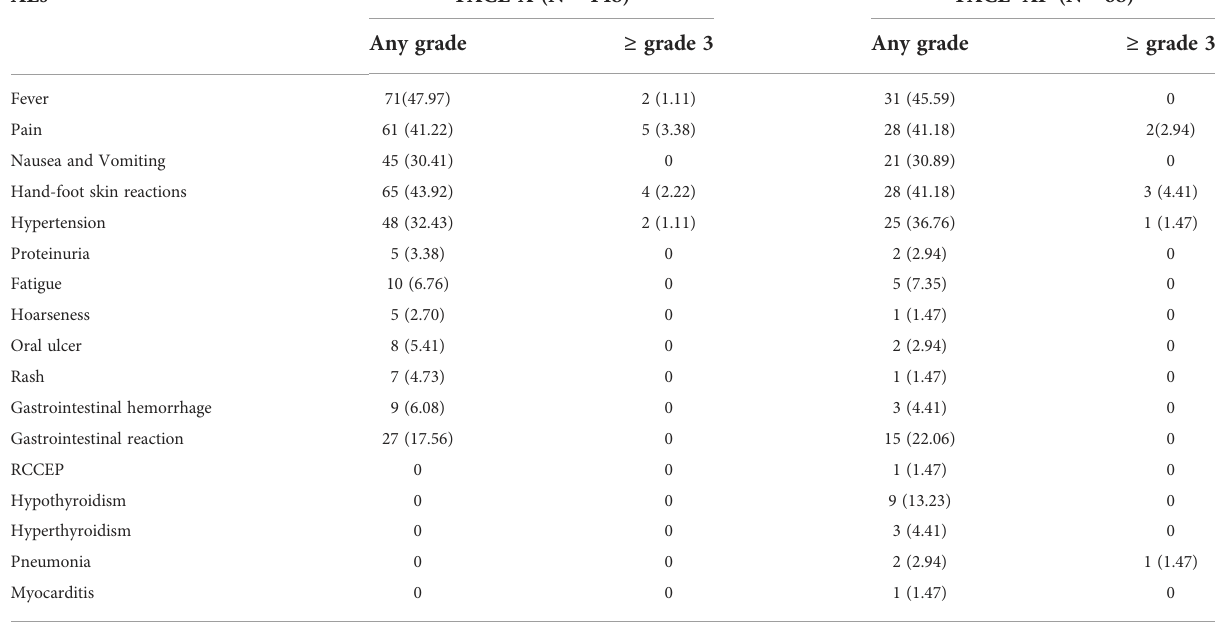
TABLE 4 Treatment-related adverse events between TACE-A and TACE-AP groups.